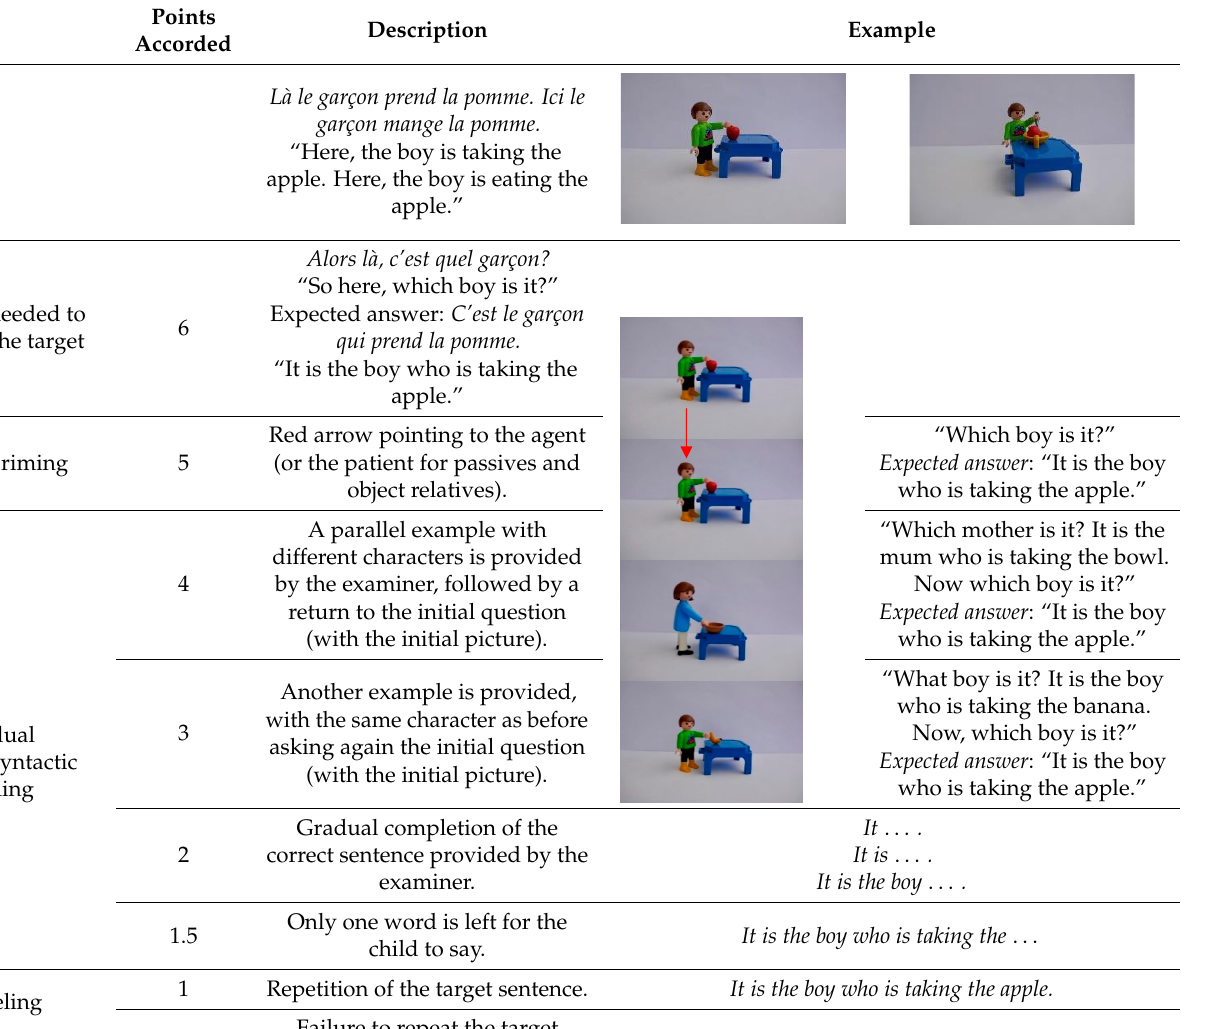
Table 3. An example of graduated prompts and scoring for a subject relative.